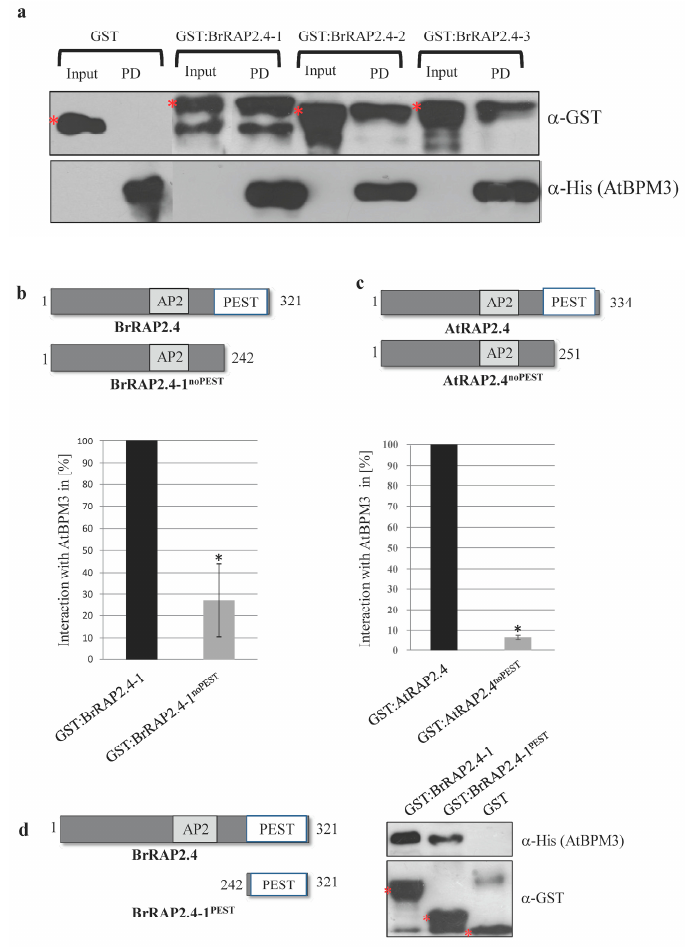
Figure 5. Characterization of protein assembly for BrRAP2.4-1, -2, and -3. ( a ) Pulldown assays with purified, recombinant His:AtBPM3 protein on beads resulted in co-precipitation of eluted GST:BrRAP2.4 proteins, while GST alone did not. Upper lane: Western-blot using an α -GST antibody, lower lane: stripped, and re-probed blot with an α -His antibody. ( b ) Upper part: schematic drawing of BrRAP2.4-1 and BrRAP2.4-1 noPEST , and lower part: quantification of reduced interaction of GST:BrRAP2.4-1 noPEST with His:AtBPM3 compared to full-length BrRAP2.4-1. BrRAP2.4-1/AtBPM3 interaction was set to 100%, and BrRAP2.4-1 noPEST /AtBPM3 put in relation to that. Data represent the average of n = 12 biological replicates. ( c ) Schematic drawing of AtRAP2.4 and AtRAP2.4 noPEST (upper part), and quantification of AtRAP2.4/AtBPM3 interaction as described in ( b ). Data represent average of n = 5 biological replicates. Asterisks in ( b ) and ( c ) indicate p < 0.05 significance based on an ANOVA test. ( d ) Pulldown analysis with GST:BrRAP2.4 proteins on beads resulted in co-precipitation of eluted His:AtBPM3 protein, shows that the BrRAP2.4 PEST motif alone is sufficient to bind AtBPMs. Red asterisks in ( a ) and ( d ) indicate full-length GST and GST-fusion proteins, respectively. PD,